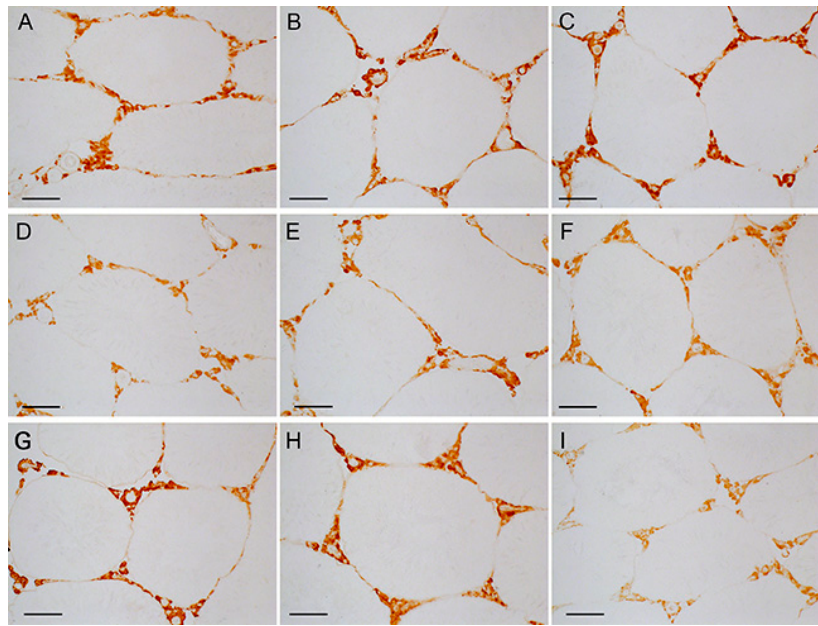
Figure 7. The immunohistochemical analysis of the distribution of LH/hCG-R in the seminiferous Table 5. ( B )—CT5, ( C )—CG5, ( D )—D5, ( E )—DT5, ( F )—DG5, ( G )—DM5, ( H )—DMT5, ( I )—DMG5. Scale bars, 100 µm.